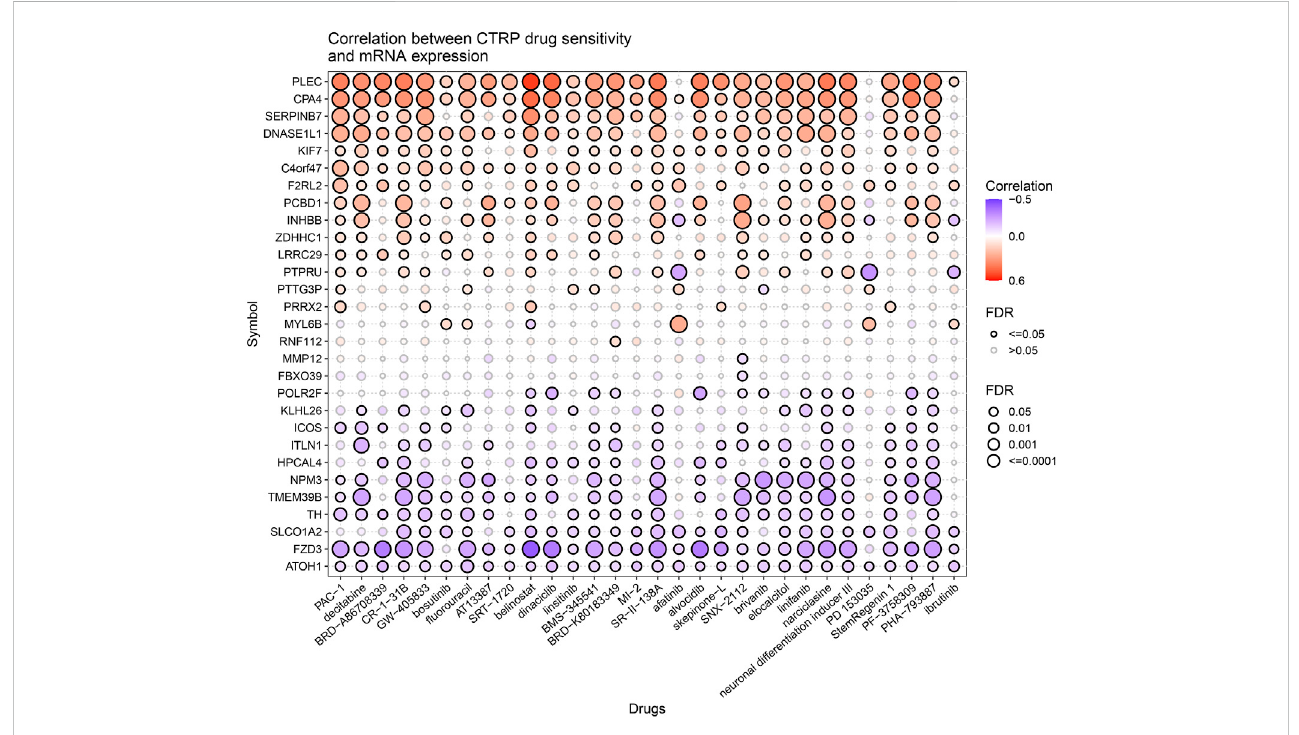
FIGURE 11 Correlation between CTRP drug sensitivity and mRNA